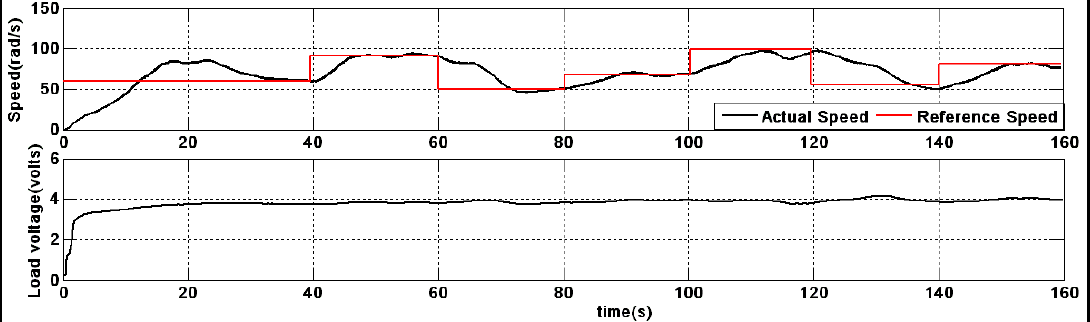
Figure 6. Speed tracking and load voltage under the PI control system.